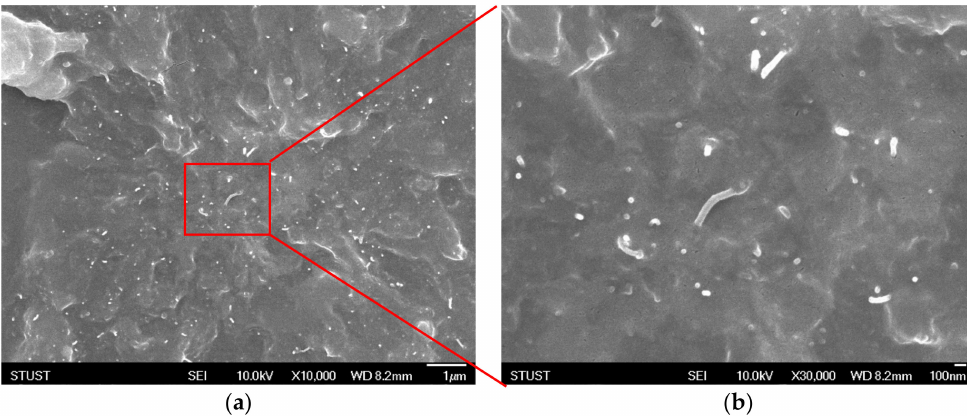
Figure 11. Cross–sectional SEM images of the THF–dispersed MWCNT/PDMS composite at magnifications of ( a ) 10,000 × and ( b ) 30,000 ×